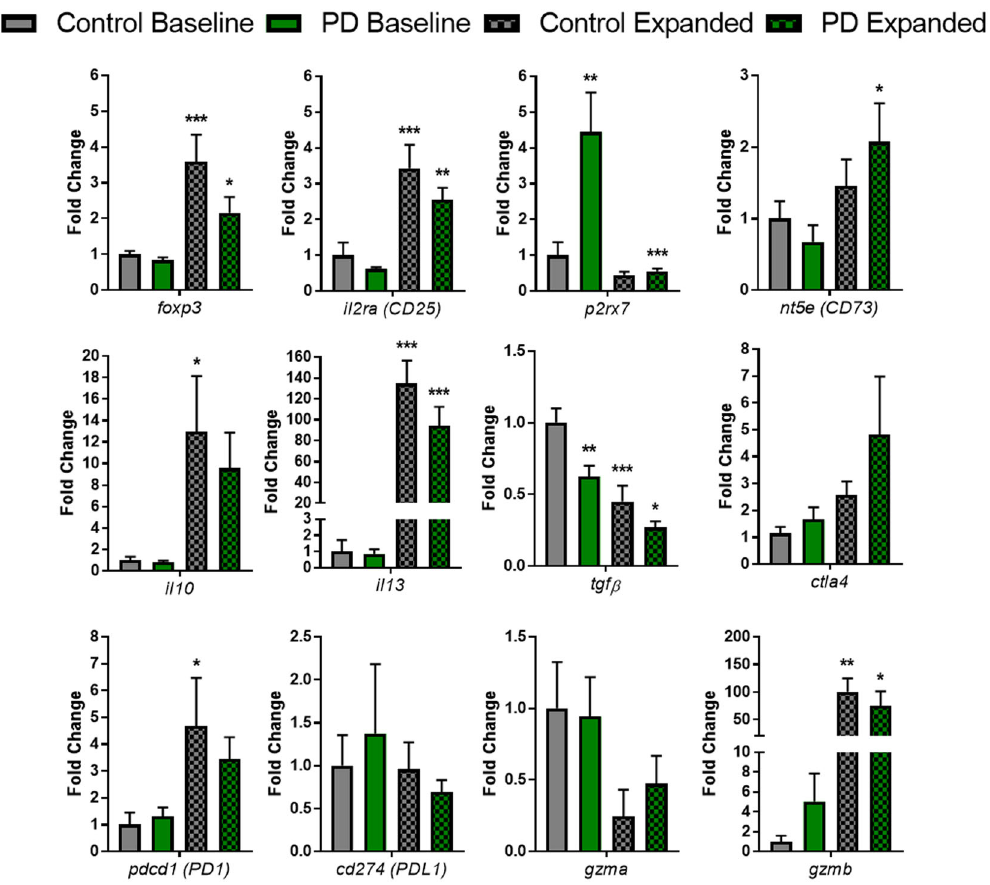
Fig. 6 Transcript analysis of expanded Tregs demonstrate enhancements of Treg anti-in fl ammatory and immunosuppressive mechanisms. RNA transcript analysis of markers of Treg health, suppressive function, and other mechanisms of Treg anti-in fl ammatory and immunomodulatory function. Increased levels of Treg health markers following expansion of foxp3 and il2ra (CD25). p2rx7 , a marker increased with Treg dysfunction, is increased in PD patients compared to controls at baseline and is reduced following expansion protocols. Markers of anti-in fl ammatory function, nt5e (CD73) il10, and il13 are signi fi cantly increased in control and PD expanded Tregs. There is a decrease in tgf β in PD Tregs compared to control at baseline and those transcripts are further reduced following expansion protocols. Additional transcript markers of Treg function are increased post expansion in Tregs such as ctla4 , pdcd1 (PD1), and gzmb while other markers are trending toward decreasing levels following expansion such as cd274 (PDL1) and gzma (C n = 6 – 8, PD n = 6 – 8). Numbers shown as averages ± SEM with one-way ANOVA with appropriate post hoc testing for multiple comparisons as appropriate. P -values are * p < 0.05, ** p < 0.01, and *** p <